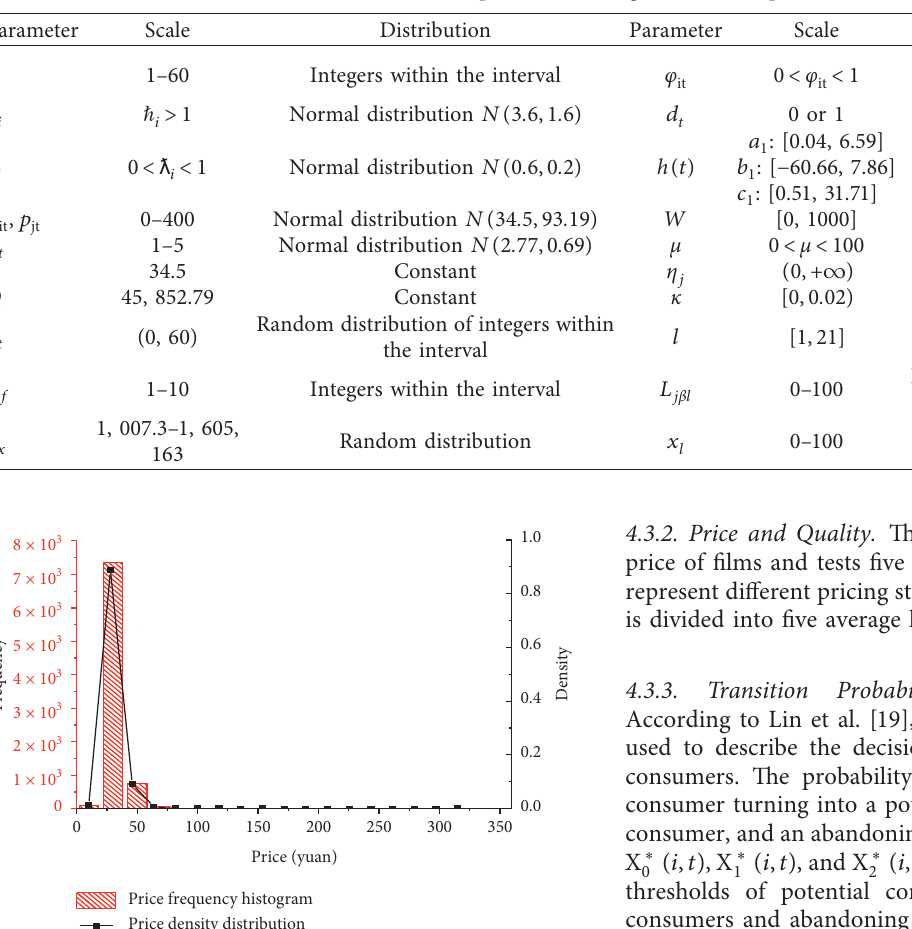
Table 2: Initial parameter settings of the basic parameters.